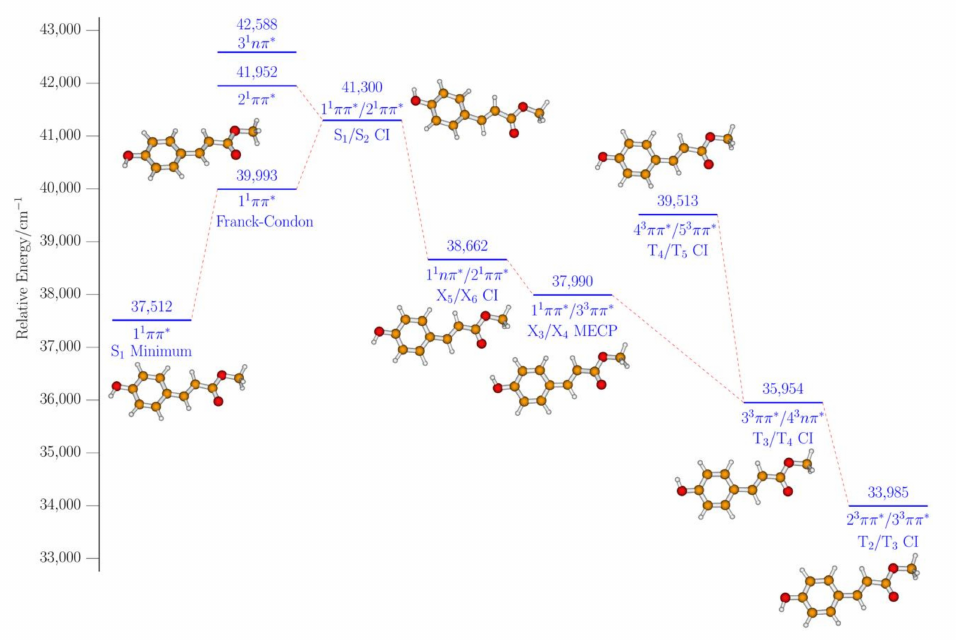
Figure 7. Energy landscape showing points relevant to the NRD of p -HMC. Geometries were optimised starting in the anti conformation. All energies are relative to the S 0 state of the anti conformer FC point. Energies, in cm − 1 , are given above the blue lines; immediately below are the states in question; and below that are the labels of the optimised points. We have also included images of the molecular structures of the optimised points, above or below the lines for clarity. From left to right are the data for the S 1 minimum; the FC point; the S 1 /S 2 CI; the X 5 /X 6 (S 1 /S 2 ) CI; the X 3 /X 4 (S 1 /T 3 ) MECP; the T 4 /T 5 CI; the T 3 /T 4 CI; and the T 2 /T 3